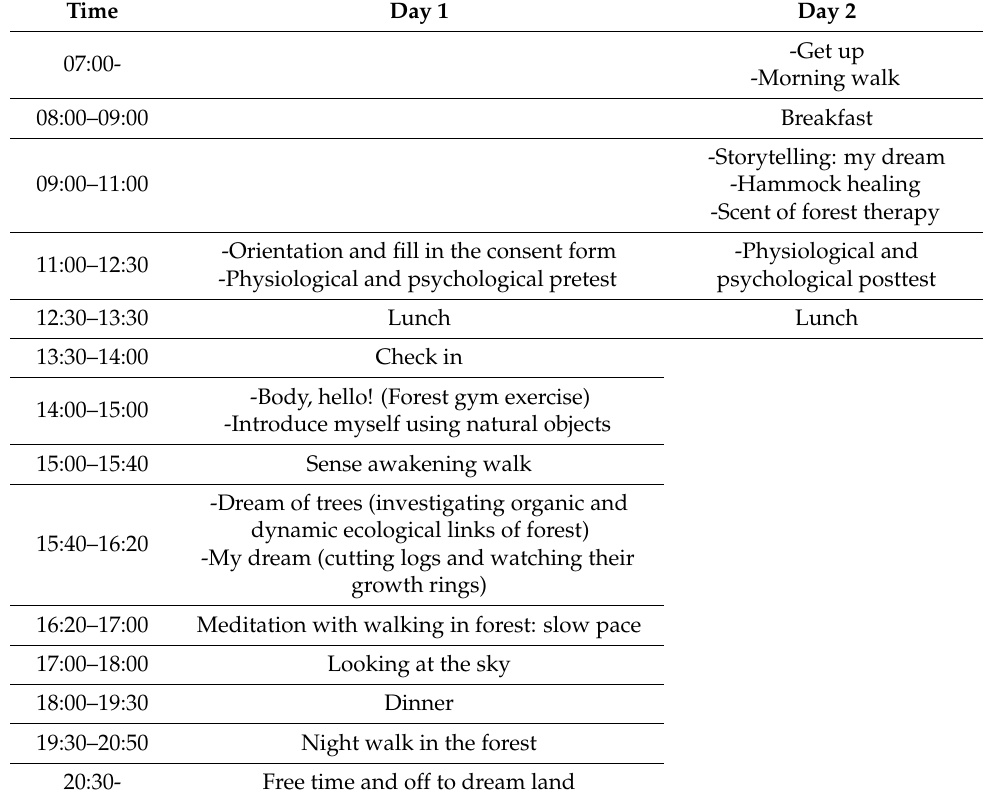
Table 2. Forest therapy